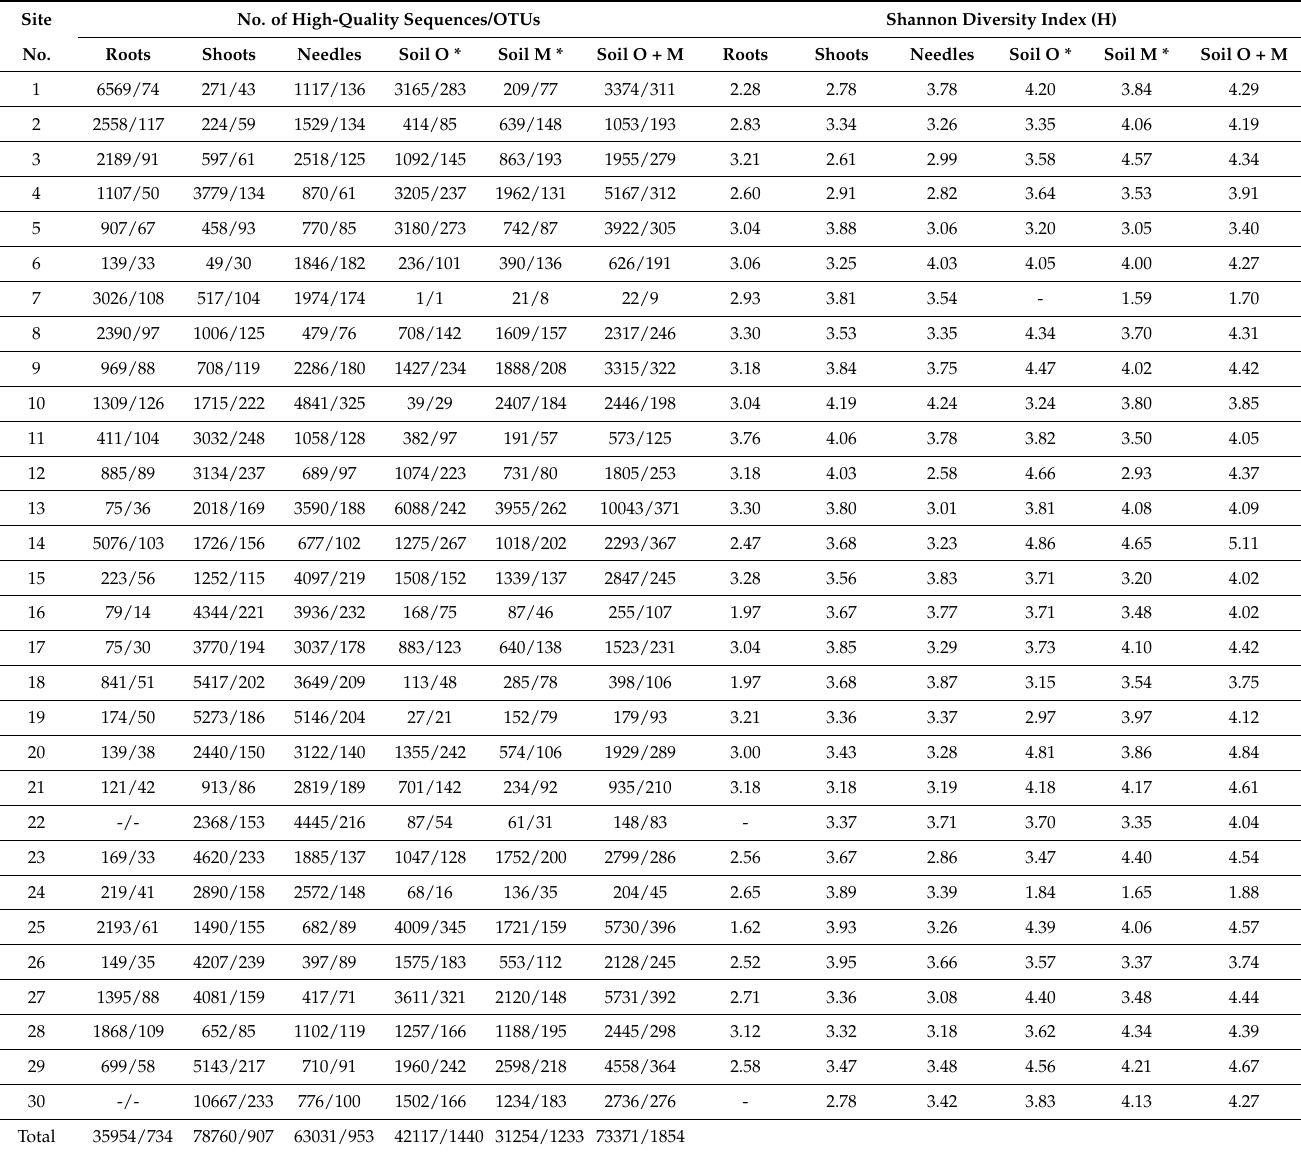
Table 2. The number of high-quality sequences and fungal OTUs from each study